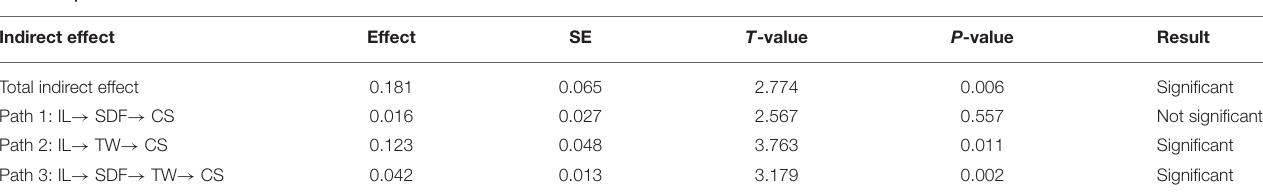
TABLE 5 | Results of the serial mediation